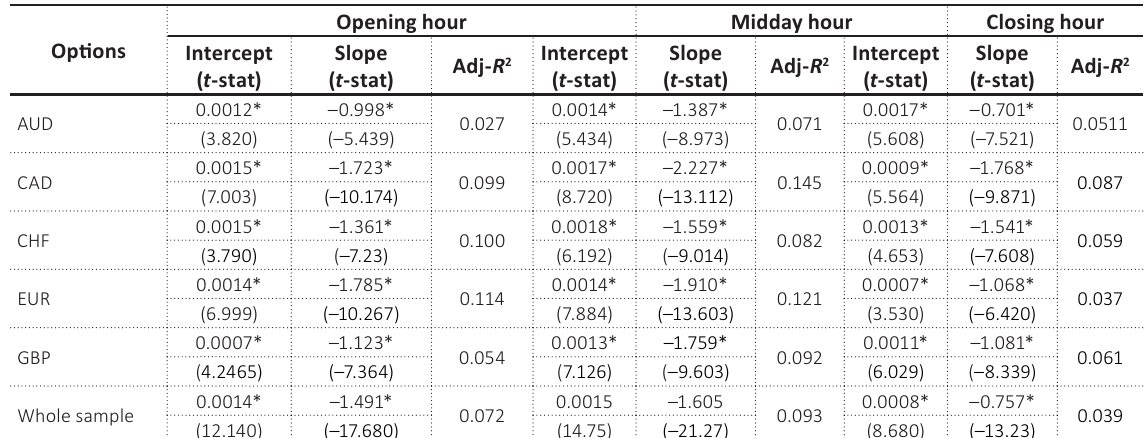
Table 4. Currency smirks’ predictive power